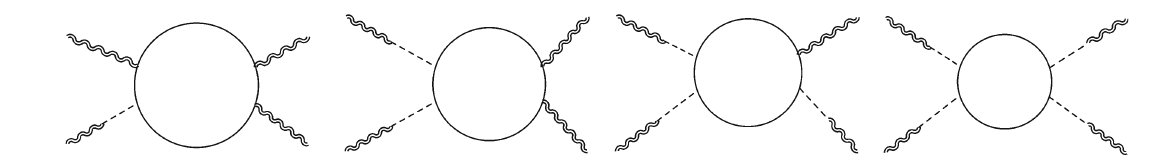
Fig. 3 The Weyl-variant contributions from S A to the renormalized vertex for the 4T with the corresponding bilinear mixings in d =